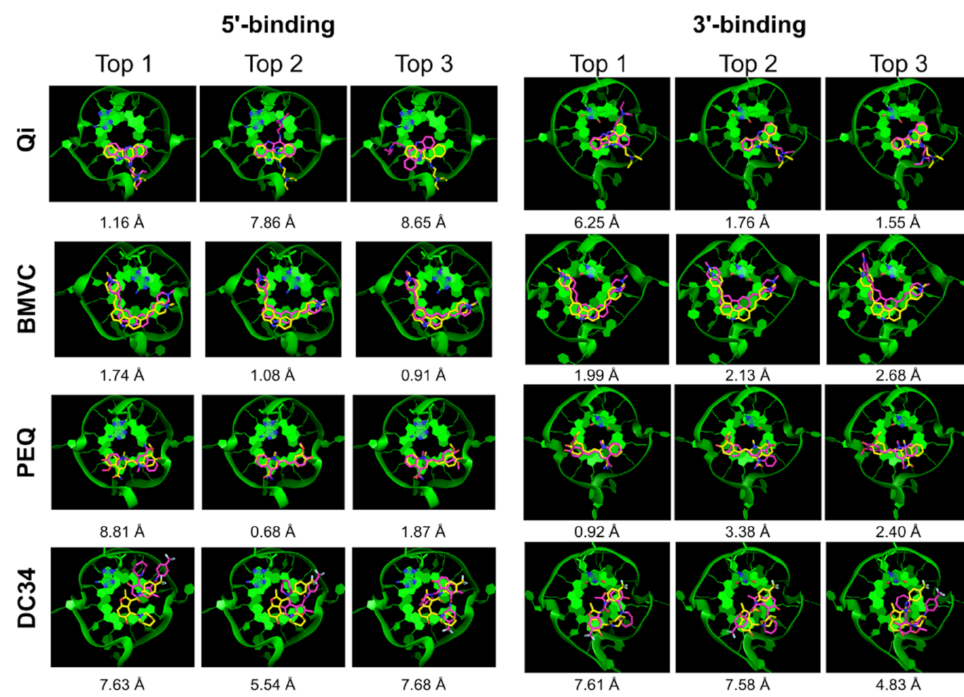
Figure 4. DOCK 6 rescored using GB/SA. Top 3 docked poses (purple) superimposed onto the NMR poses (yellow). The G4 DNA is shown as green ribbon.